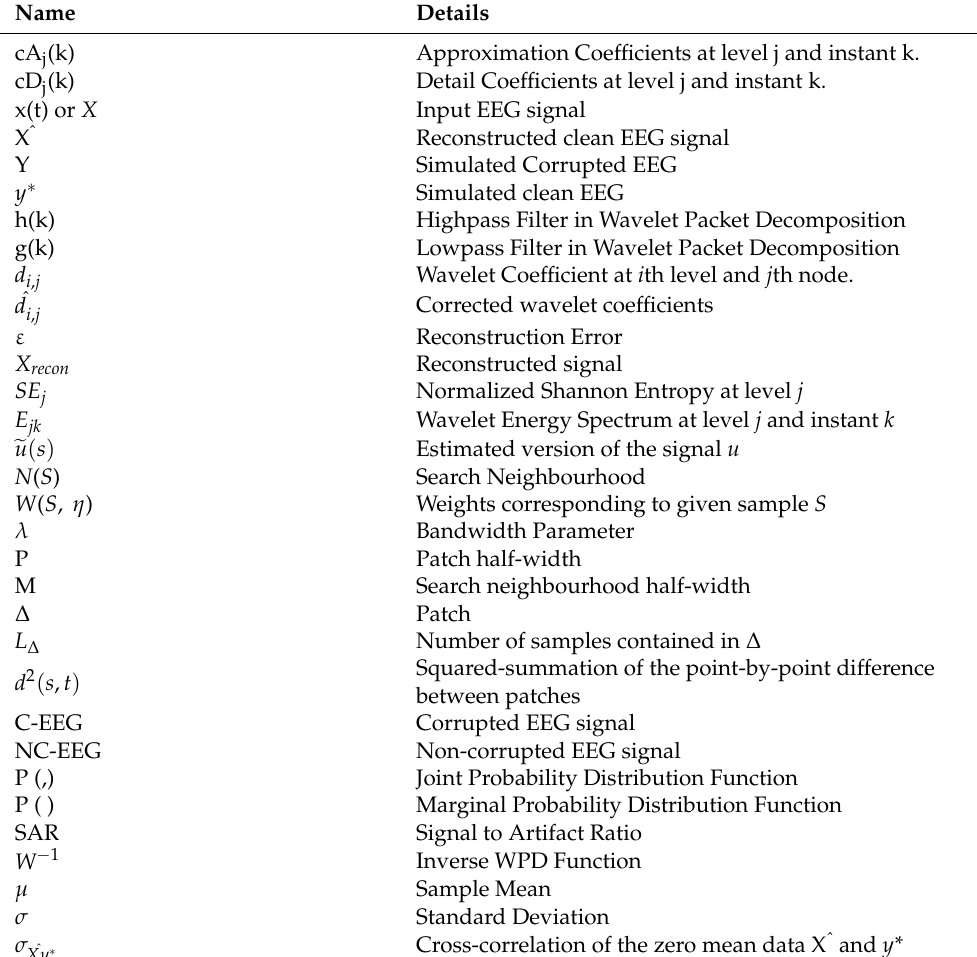
Table 2. Notations and